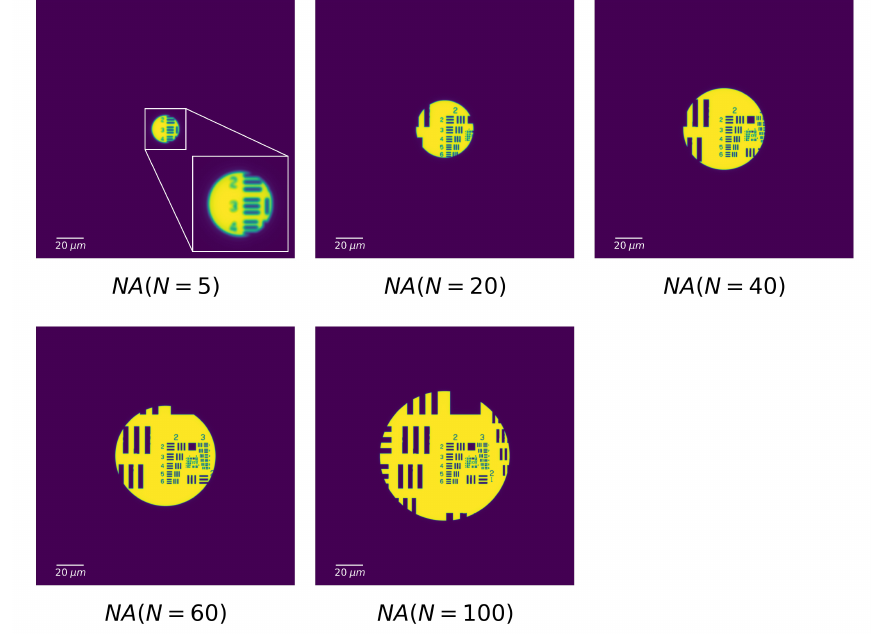
Figure 8. False color numerical images of the USAF 1951 test target imaged by refractive lens. The NA of the refractive lens equals to the NA of the FZP when the number of zones of FZP is 5, 20, 40, 60, and 100. Each image dimension is 200 × 200 µ m 2 .